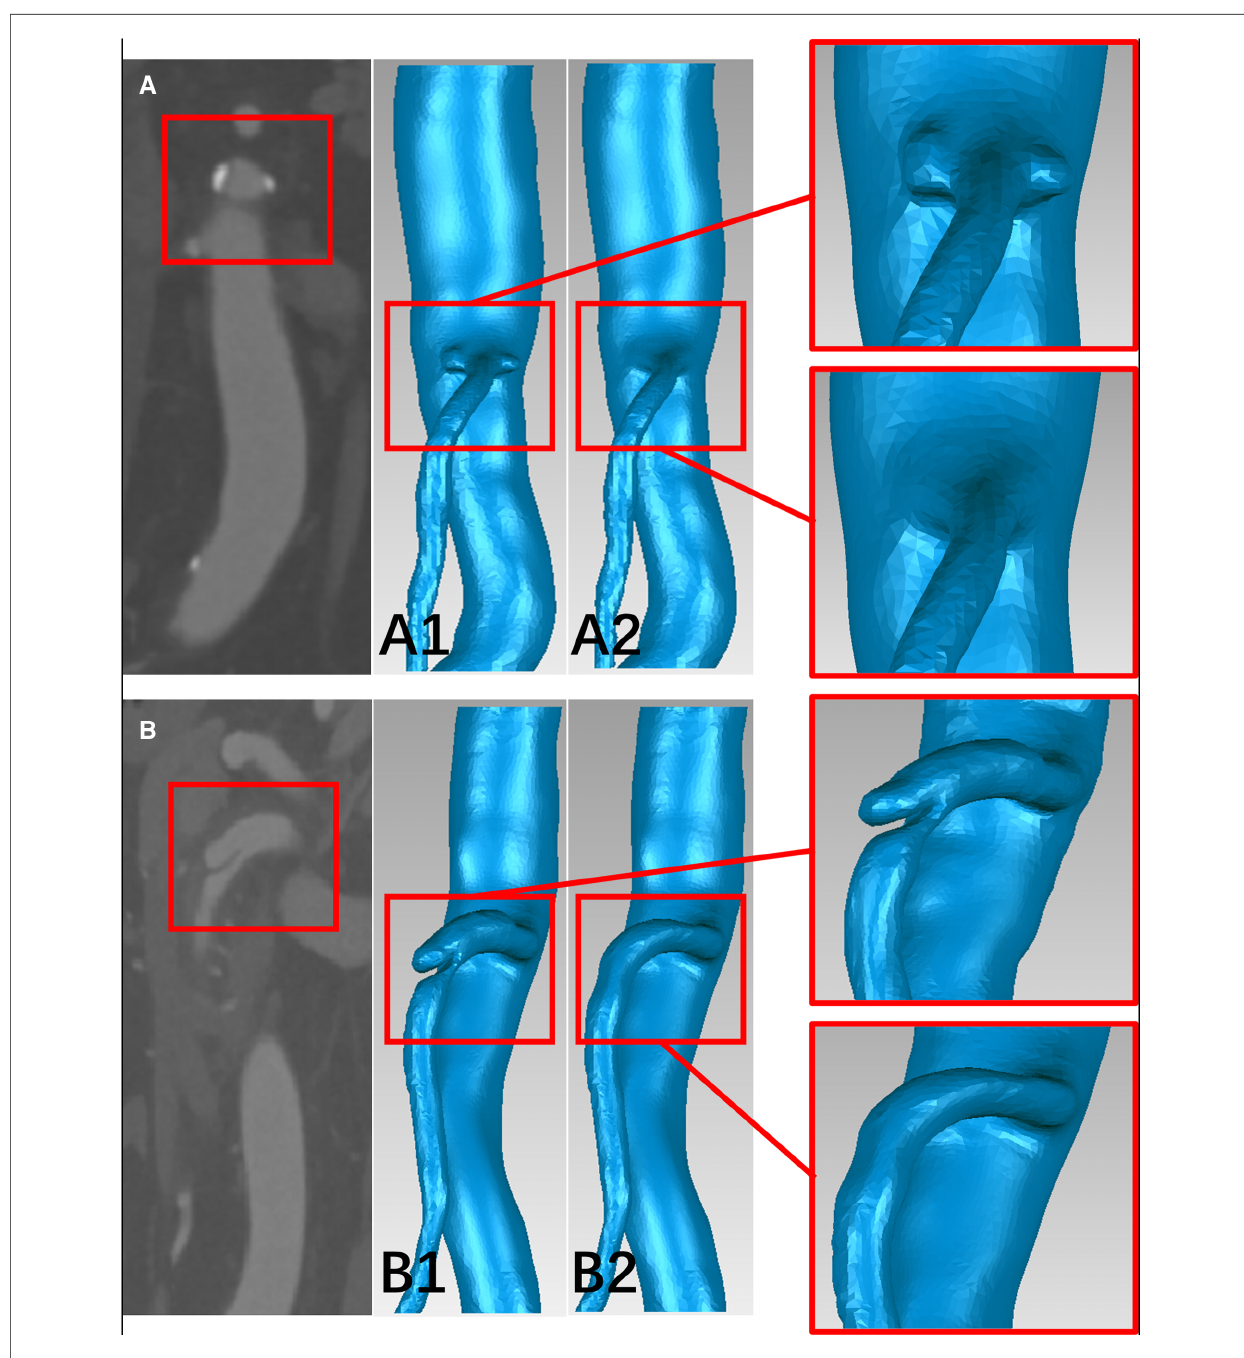
FIGURE 2 The schematic diagram of the progress of removing the plaques and dissections from the models. ( A,B ) CTA image of plaques at the root of the superior mesenteric artery (SMA) and dissection at the curved segment of the SMA. ( A1,B1 ) The superior mesenteric atherosclerotic stenosis (SMAS) and superior mesenteric artery dissection (SMAD) models before repairing. ( A2,B2 ) the SMA models before the onset of SMAS and